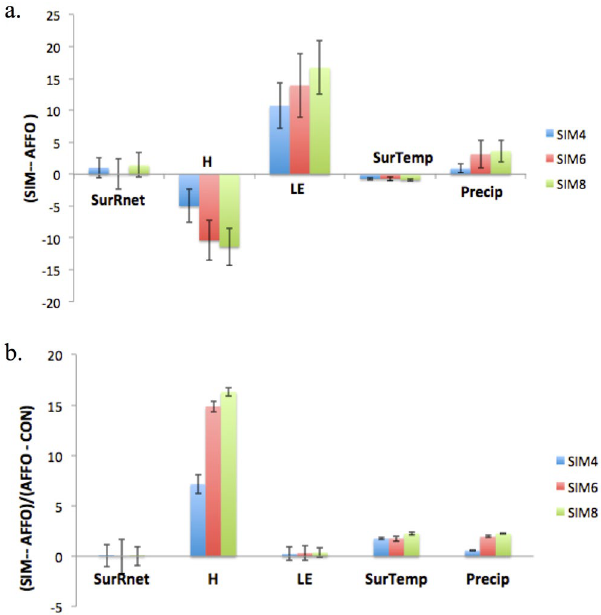
Figure 3. ( a ) Relative differences of SIM4 (albedo vegetation), SIM6 (vegetation height) and SIM8 (root-depth) from CON, compared to differences of AFFO from CON, in net radiation at the surface (SurRnet) [W m − 2 ], sensible heat flux (H) [W m − 2 ], latent heat flux (LE) [W m − 2 ], surface air temperature (SurTemp) [°C] and precipitation (Precip) [mm day − 1 ]. ( b ) The fraction of change for SIM – AFFO from the base deviation of AFFO -